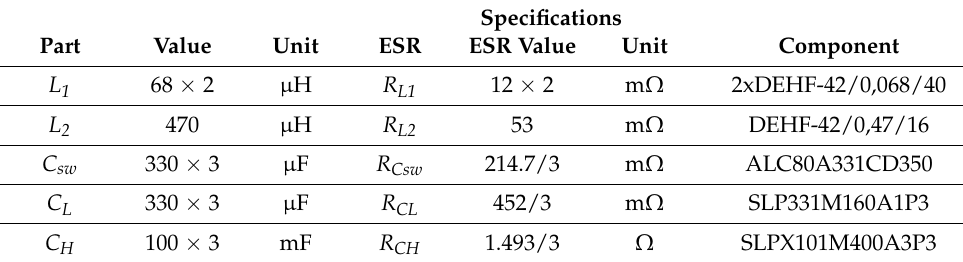
Table 2. BHSC stability analysis prototype characteristics.